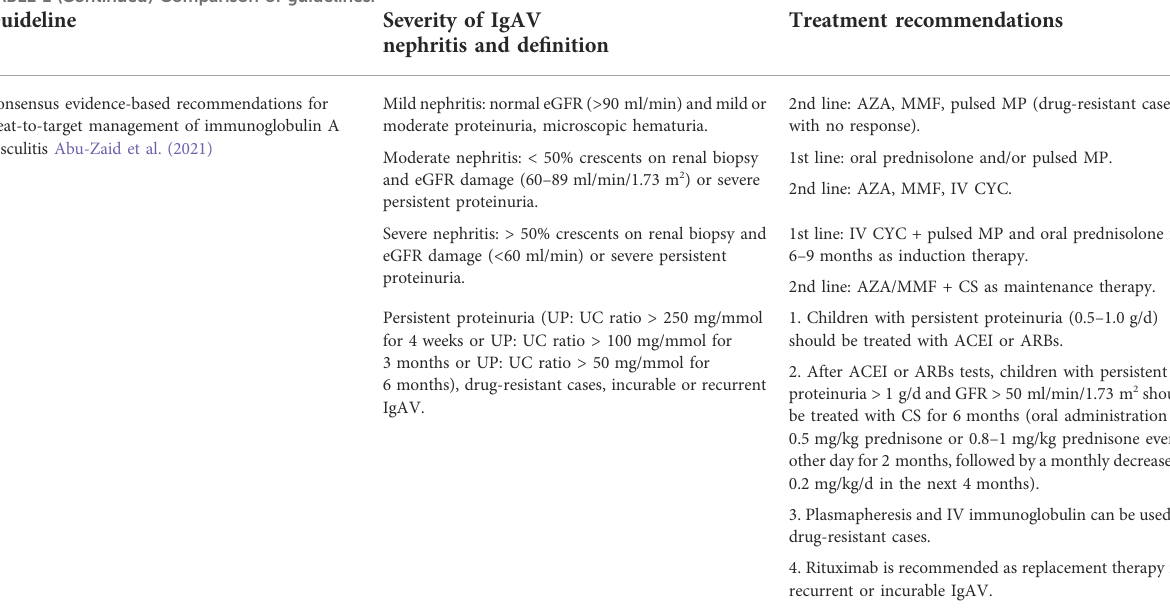
TABLE 1 ( Continued ) Comparison of guidelines. Guideline